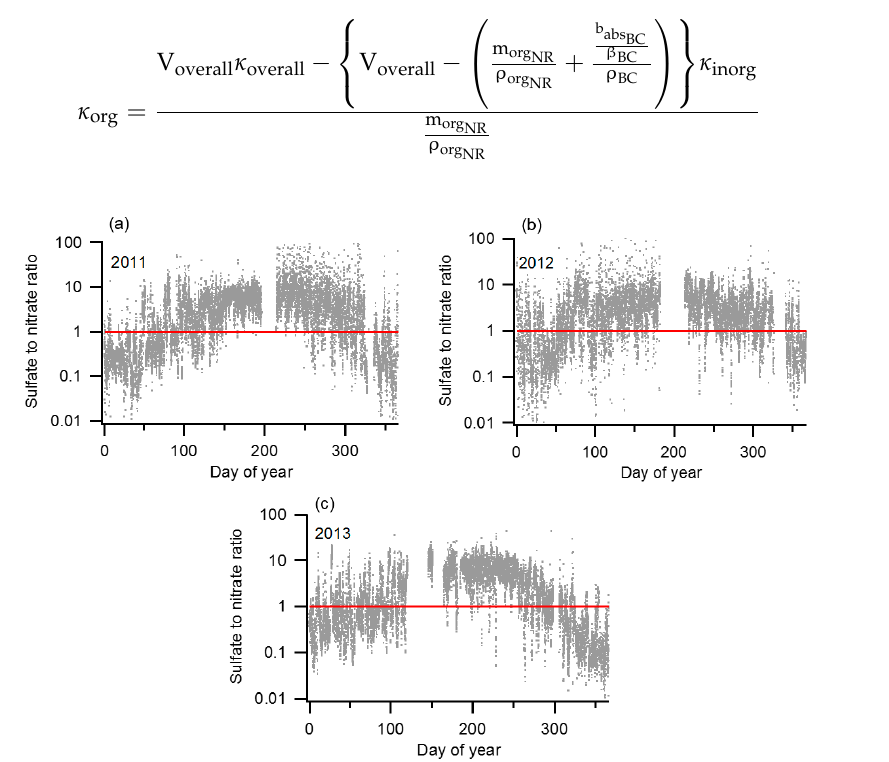
Table 2. Mass concentration fraction from ACSM measurements at SGP.